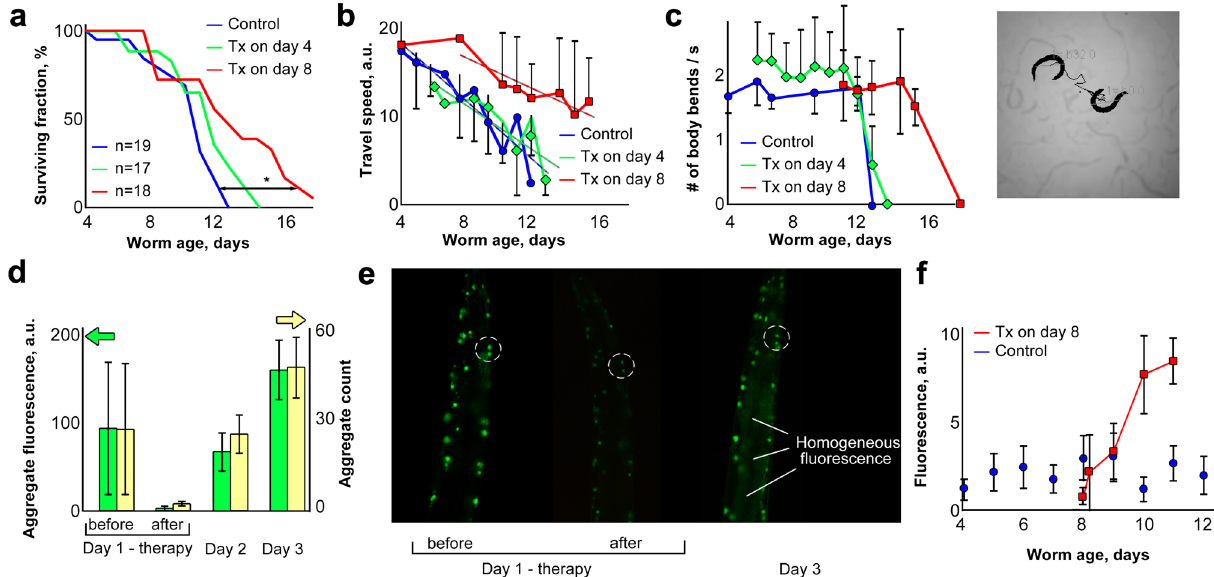
Figure 3. Laser disruption of polyQ::YFP aggregates, in 4 and 8 day-old AM141 nematodes. ( a ) Survivals for lifespan (*Cox–Mantel log-rank p ≈ 0.003, day 8 laser vs. control). ( b , c ) Video analyses of worm-motility data (travel speed, flexion frequency). Each day-8 laser group differed from its control ( b , p < 6E–5; c , p < 0.01). Dashed lines in ( b ) show linear trend analysis for travel speed. Inset (right of c ) shows a video frame with two worm positions connected by a midpoint trace. ( d ) Aggregate count (yellow) and total fluorescence (green) per worm. Each day-1/after differed from day-1/before ( t test p < 0.05). Each day-2 and day-3 post-treatment group differed from day-1/after ( p < 0.005). ( e ) Fluorescence images of laser-treated worms before, immediately after, and 48 h after laser therapy (dashed circles highlight two aggregates with post-therapy recovery of fluorescence). ( f ) Release of non-aggregate (diffuse) fluorescence. Error bars show SDs, unless omitted for clarity. Treatment differs from control at days 10–11 (combined p <